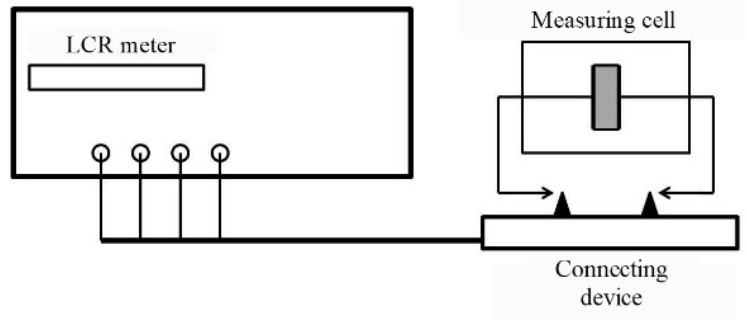
Figure 8. Scheme of the setup for permittivity ε measurement.